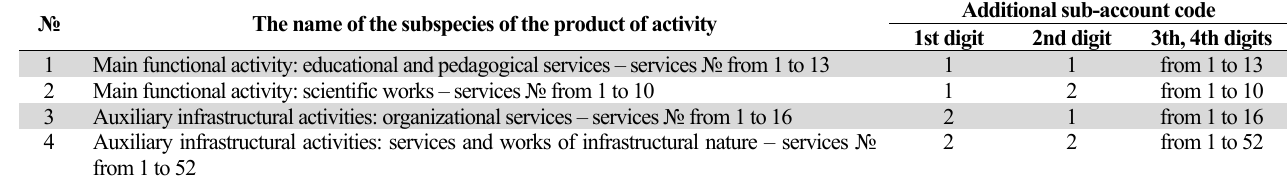
Coding scheme of sub-accounts for identification of subtypes of products of SIHE activity within the limits of analytical accounting № The name of the subspecies of the product of activity 1 from 1 to